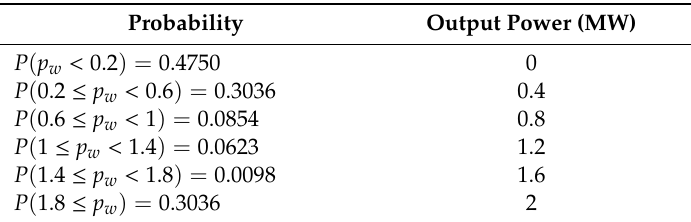
Table 1. Probability of turbine output power levels.